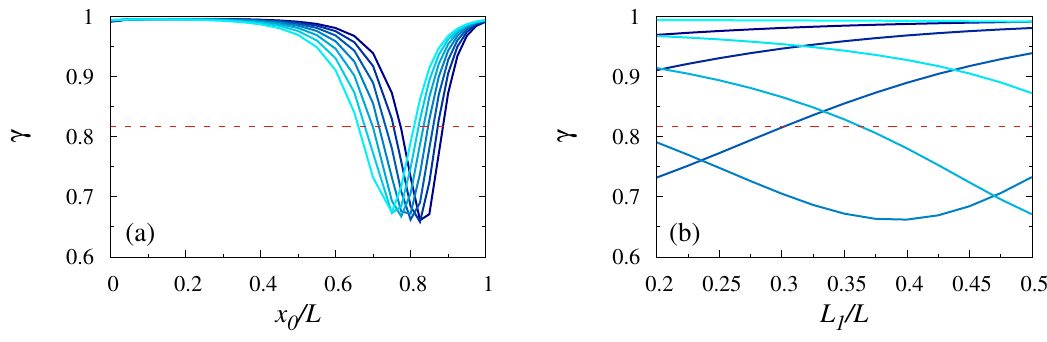
The coefficient of variation of the FPTD for left/right asymmetric channels with h 0 / L = 0.25 and h 1 / h 0 = 0.8. Panel ( a ): Coefficient of variation γ as function of x 0 / L for L 1 = 0.2,0.25,0.3,0.35,0.4,0.45,0.5 (lighter colors correspond to smaller values of L 1 ) for ∆ S = 1.7 and N = 90. Panel ( b ): Coefficient of variation γ as a function of L 1 for ∆ S = 1.7, N = 90 and x 0 / L = 0.5,0.6,0.7,0.8,0.9,1 (lighter colors correspond to larger values of x 0 / L ) and. The horizontal dashed line in both panels represents the value of γ for a constant section channel (for this case γ is independent of the polymer length N